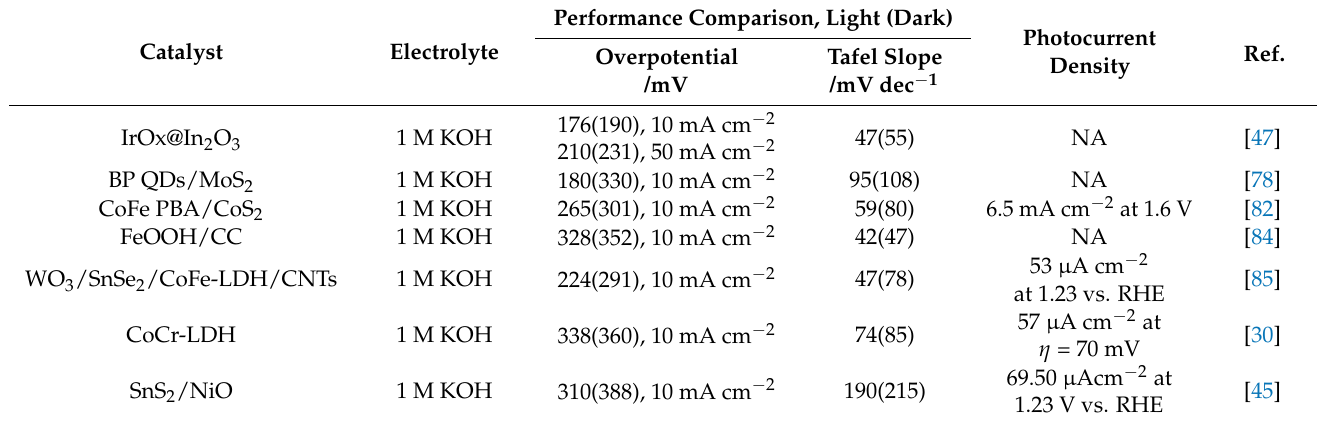
Table 2. The main catalysts, experimental conditions, and activities of photogenerated carrier-assisted electrocatalysts for